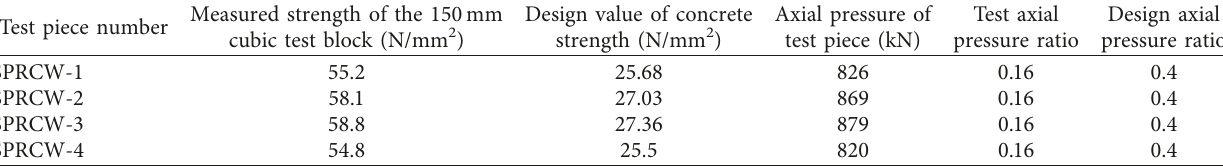
Table 3: Concrete strength and axial pressure